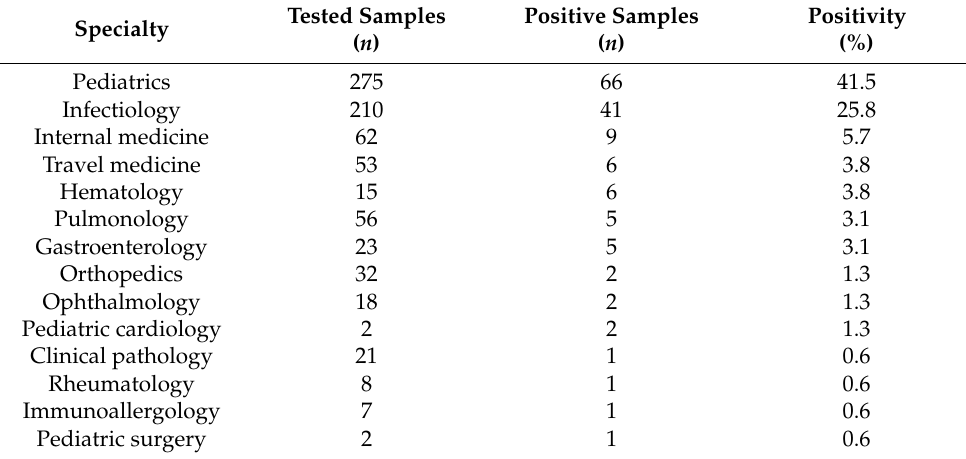
Table 1. Number of tested samples and positive samples for Toxocara spp. according to the requested medical specialty from 2010 to